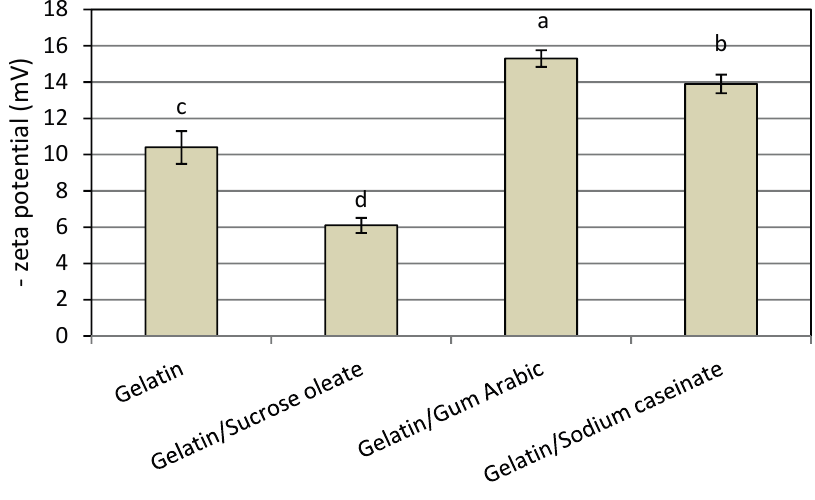
Figure 4. Mean zeta potential of freshly prepared astaxanthin nanodispersions stabilized with different gelatin based emulsifying